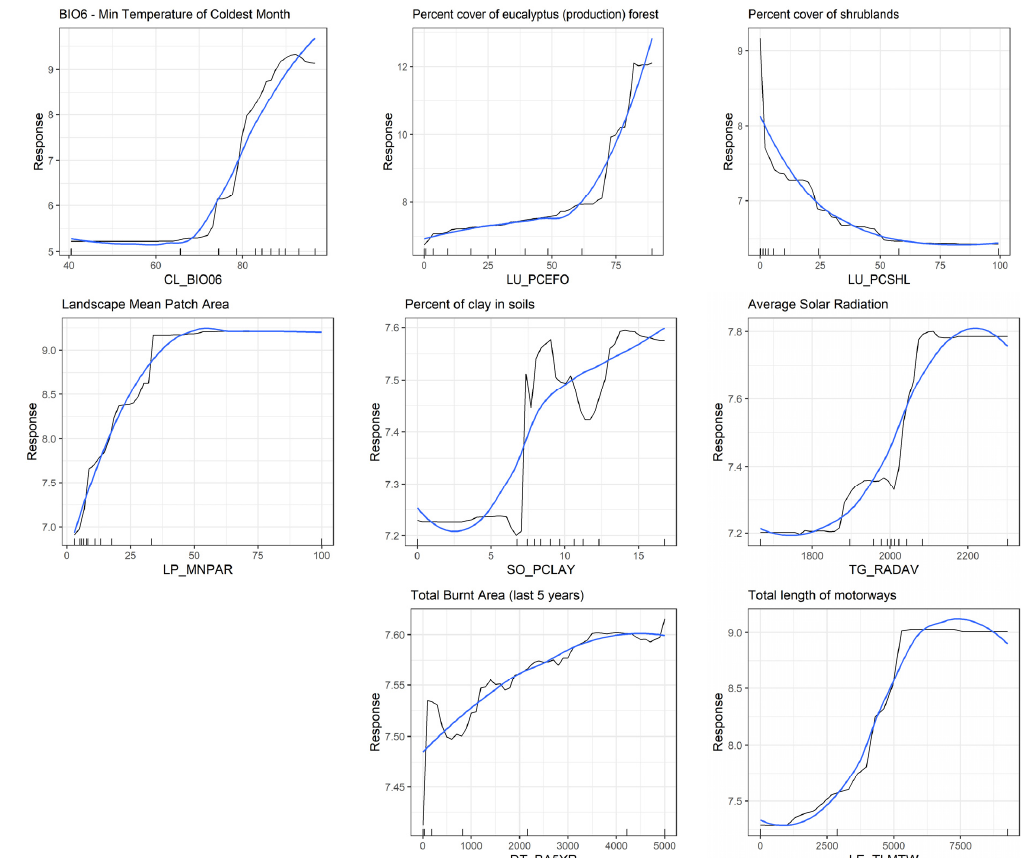
Figure 6. Importance scores for the 20-selected predictive variables calculated from the Random Forest model. Average (grey bars) and standard deviation values (‘whiskers’) are presented for the 1000 rounds performed with the random forests algorithm. Acronyms for predictor variables are presented in Table 2.